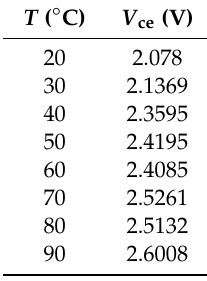
Figure 12. Comparison of V ce at different temperatures. Table 3. Actual value of V ce at different temperatures.